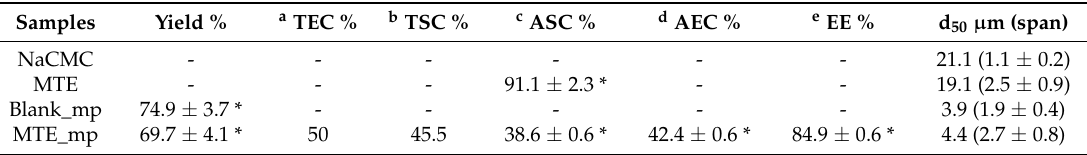
Table 1. Composition and characteristics of raw materials and